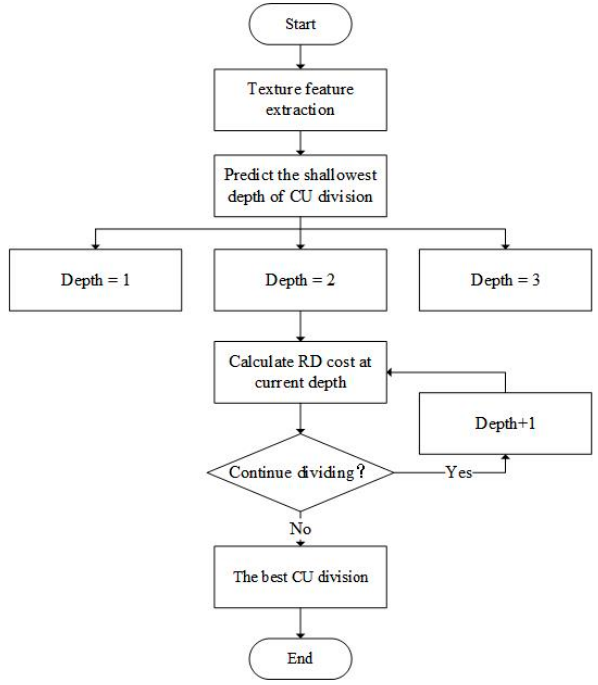
Figure 5. Flow chart of CNN-based intra prediction CU fast partition algorithm.